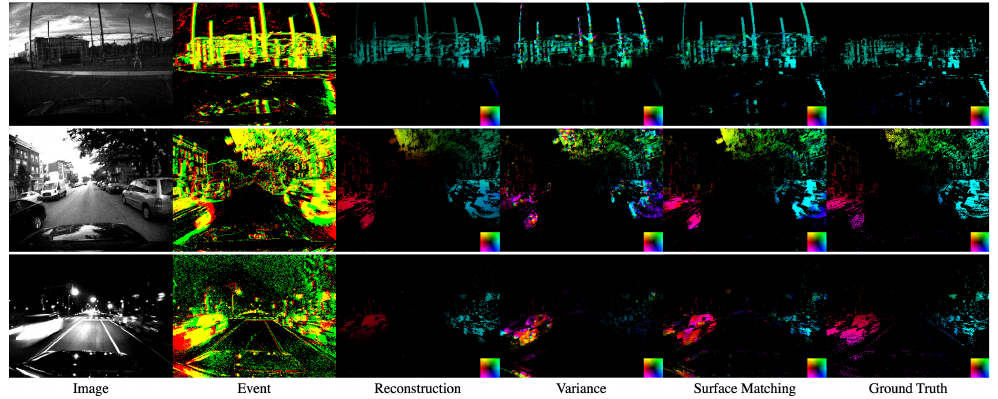
Figure 7. Qualitative results from Multi-Vehicle Stereo Event Camera Dataset (MVSEC). Left to right: the image, events, the optical flow by Reconstruction [9], Variance [10], Surface Matching (ours). Events are shown as accumulation for τ + ∆ t . The red and green events indicate each polarity and yellow shows that both of them occur at the pixel. Optical flow is colored by direction as the lower right colormap in each